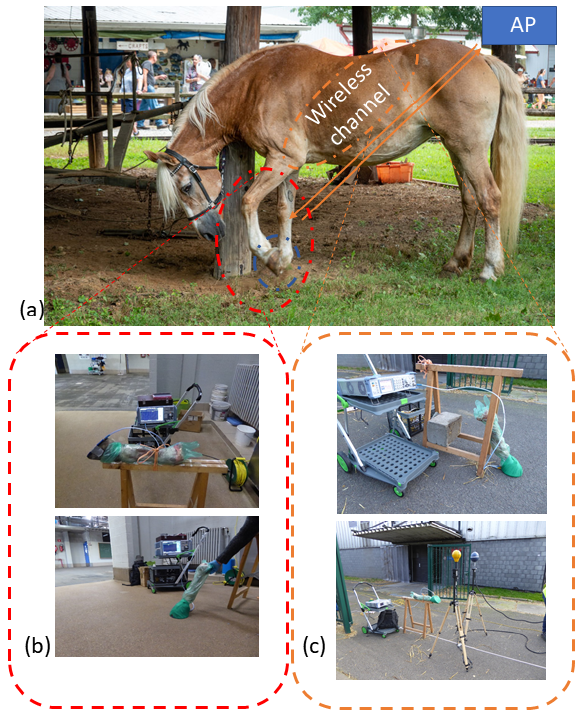
Figure 3. ( a ) the overall concept of the project; a mobile sensor embedded in the horseshoe communi- cating the behavioral data of the horse to a access point located somewhere in the pasture the horse resides. This work studies the combined antenna–channel modeling of this situation; ( b ) shows the constructed pad, the severed horse leg, covered in a hygienic veterinary glove; part of the hoof is uncovered by the glove and the hoof pad is attached to it with tape. The top picture is the air-case setup. The iron is attached by means of the green tape as seen on the ground-case setup, the bottom picture; ( c ) the path loss measurement setups as discussed in Section